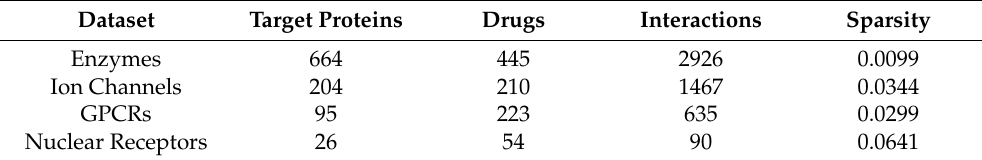
Table 1. Statistical information for the four gold-standard datasets: the number of target proteins, drugs, and interaction pairs. Sparsity is the ratio of positive DTIs to all possible interactions. Dataset Target Proteins Drugs Interactions Sparsity Enzymes 664 445 2926 0.0099 Ion Channels 204 210 1467 0.0344 GPCRs 95 Nuclear